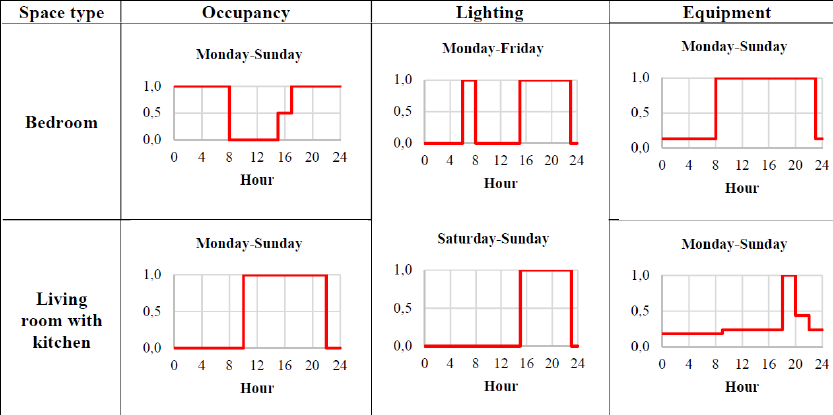
Fig. 3. Occupancy, lighting and equipment use profile in the simulated